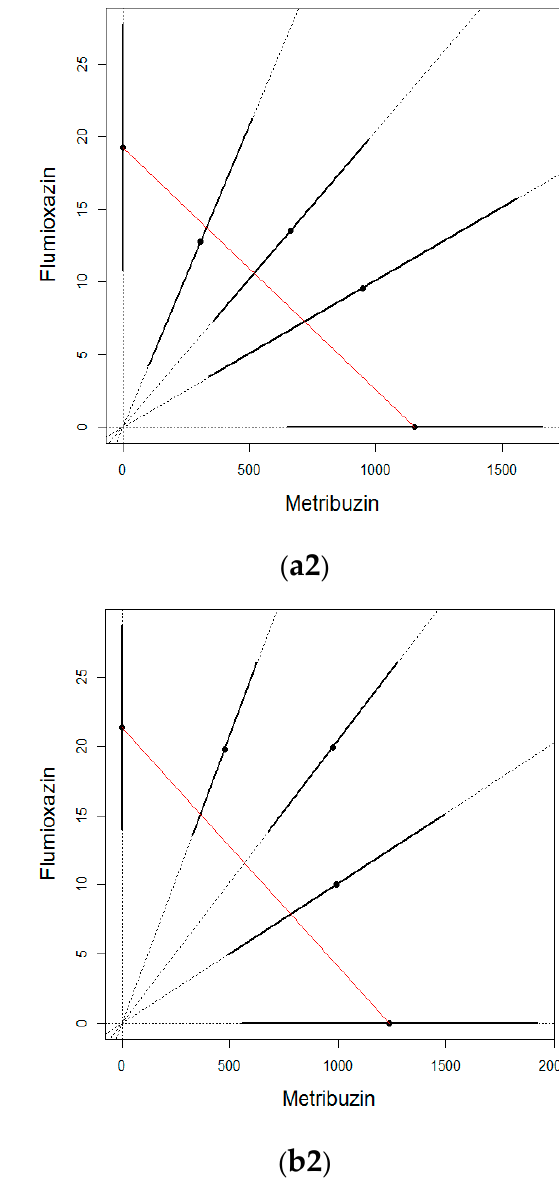
Figure 5. ED 50 isobologram showing the interactions of metribuzin:flumioxazin on F v /F m of potato in 4 h ( 1 ) and 8 h ( 2 ) in first ( a ) and second experiment ( b ). The straight line of isobologram indicates additivity. The lines around the mixture points are 95% confidence intervals .